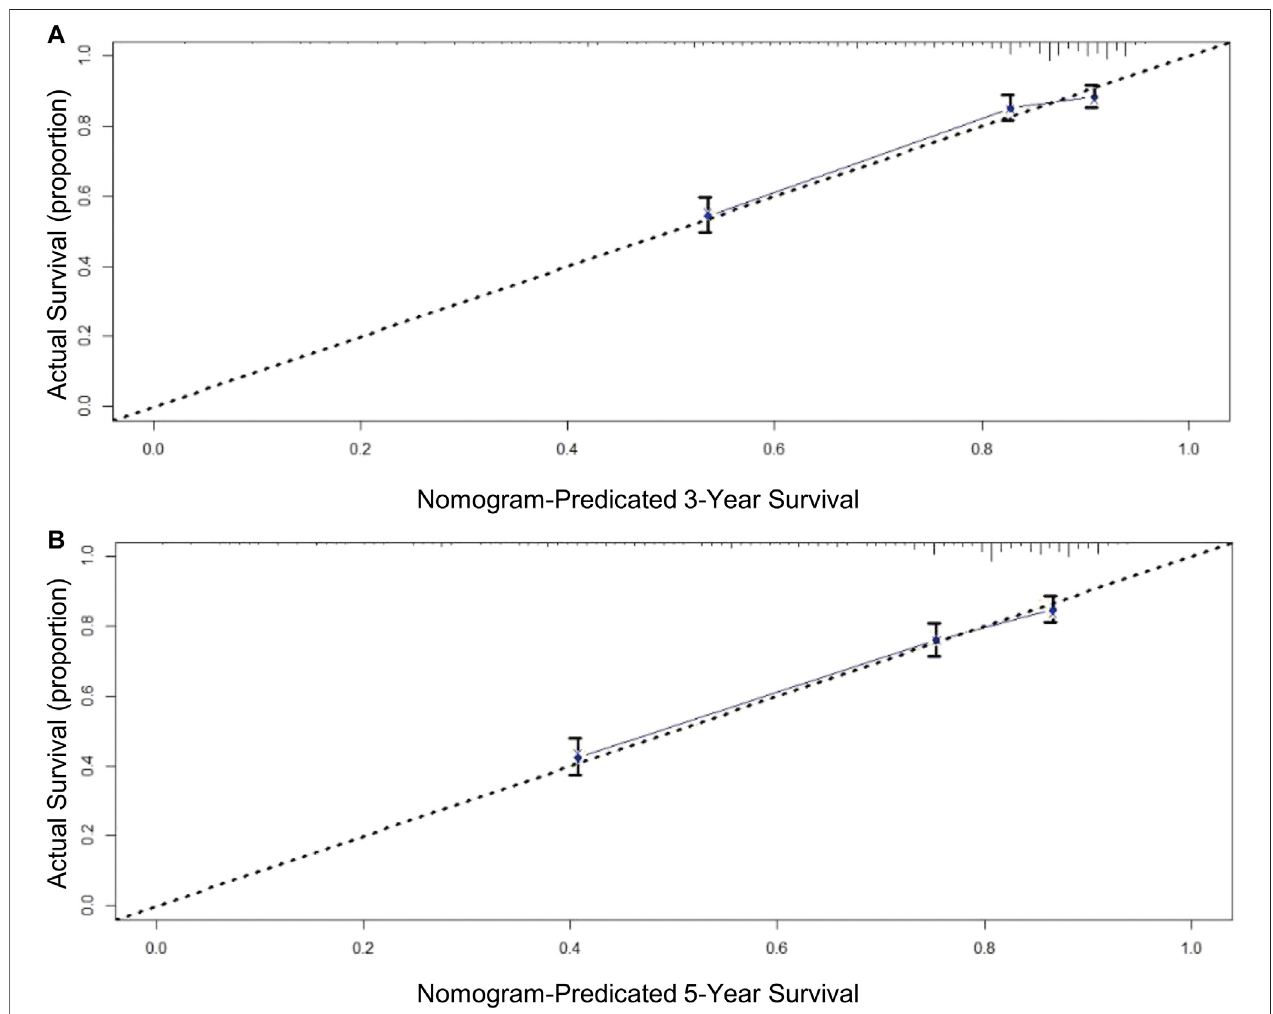
FIGURE 4 | Calibration curves for OS prediction: (A) 3-year OS in derivation cohort; (B) 5-year OS in derivation cohort.